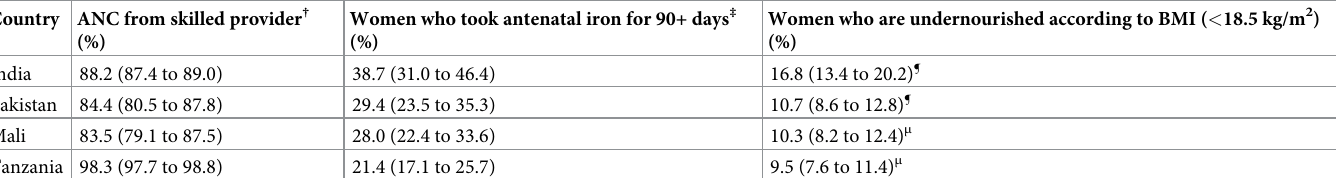
Table 1. Baseline coverage of ANC from skilled provider, coverage of IFA, and proportion undernourished by country with 95% CIs. Country ANC from skilled provider † (%)